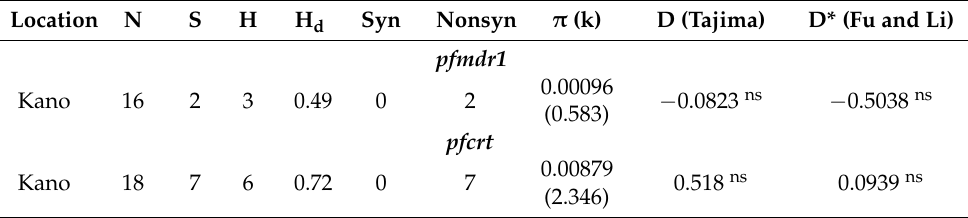
Table 1. Summary statistics for the polymorphism of pfmdr1 and pfcrt